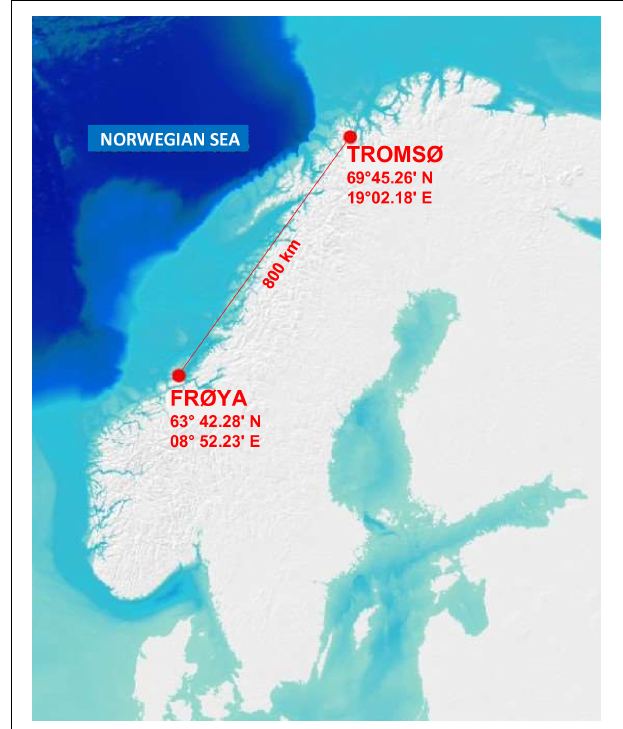
FIGURE 1 | Location of experimental sites in